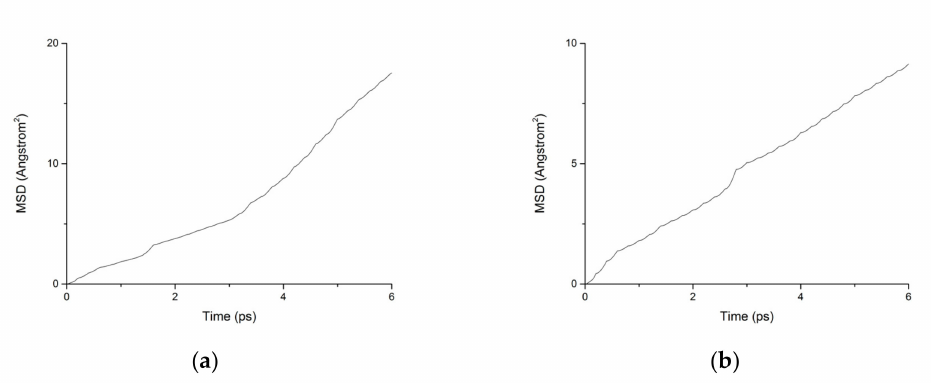
Figure 12. MSD diagram of particles in C-S-H nanopores under fatigue loading. ( a ) Water. ( b )